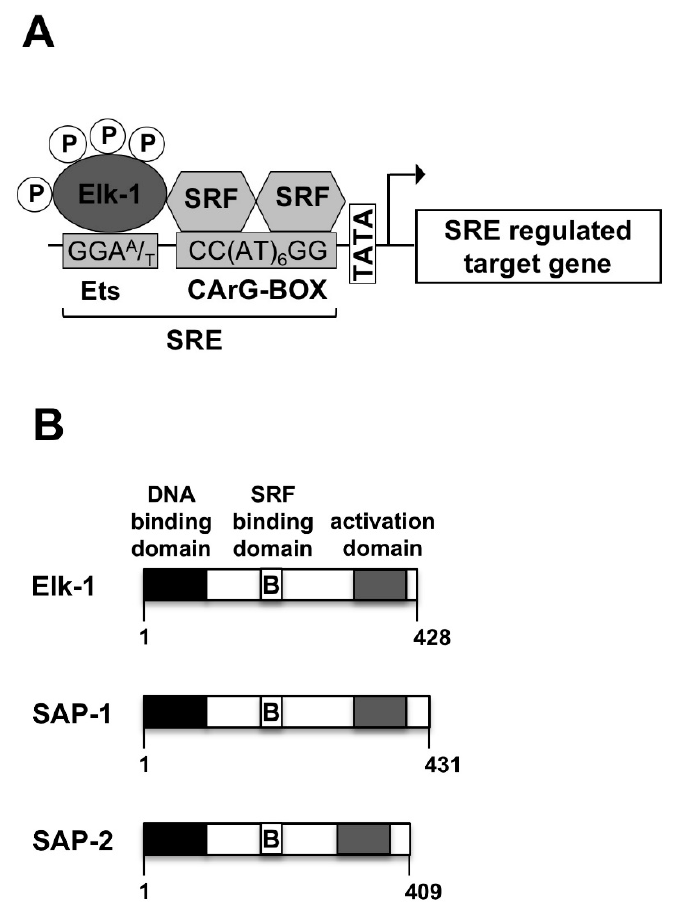
Figure 1. The serum-response element (SRE) provides binding sites for the serum response factor (SRF) and Elk-1. ( A ) The SRE. ( B ) Modular structure of Elk-1 and related ternary complex factors, showing the N-terminal DNA binding domain, the C-terminal activation domain and the B domain that is required to interact with the SRF